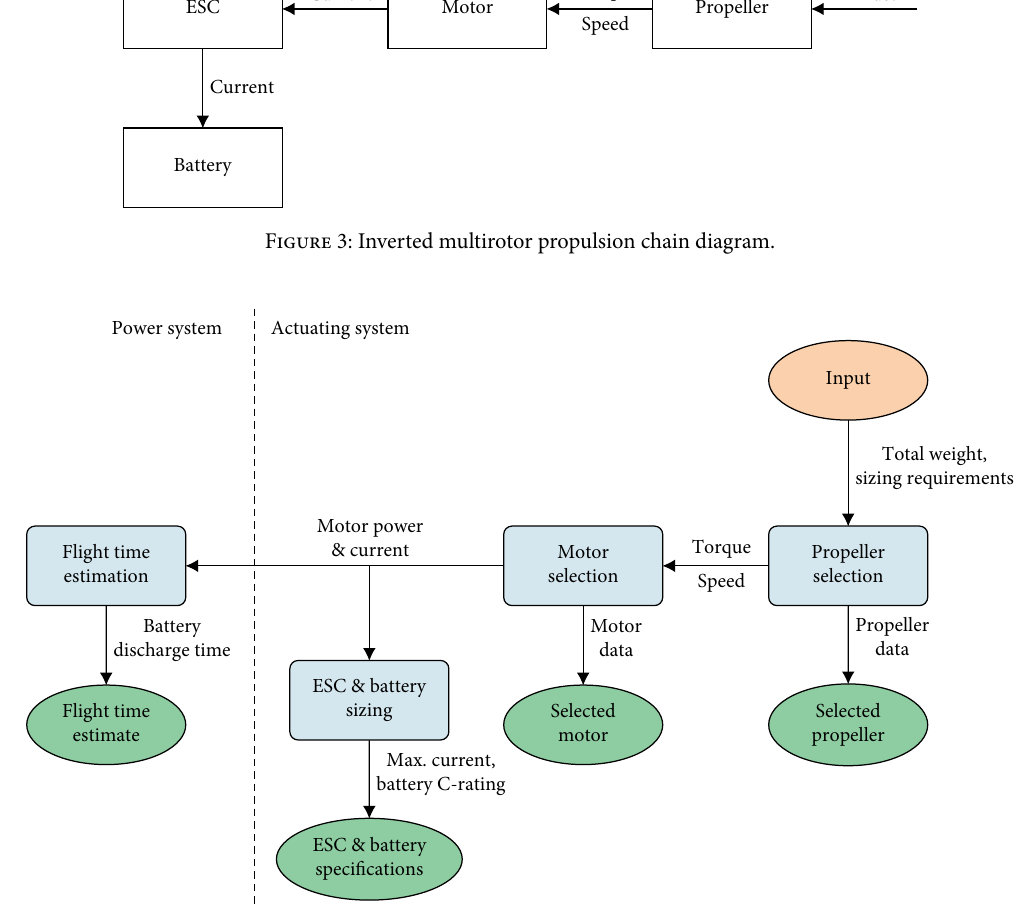
Figure 4: Simplified sizing methodology flowchart with division into two